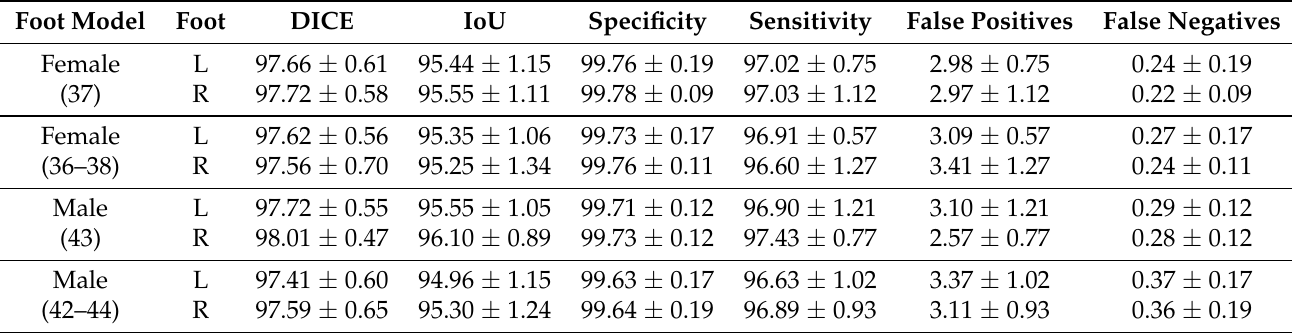
Table 4. Overlap measures for the models associated with the right and left feet, for female and male groups of subjects whose most common European foot sizes were 37 and 43, respectively. An intermediate range was correspondingly considered, that is, between 36 and 38 for the female model and 42 and 44 for the male. Average values and their corresponding standard deviations are expressed as percentages.